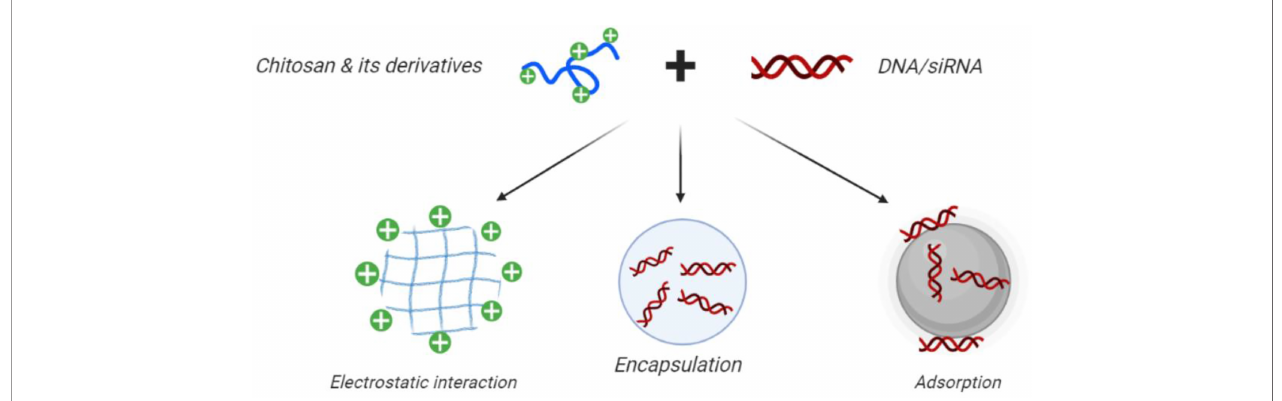
FIGURE 4 | Use of CH in gene therapy and gene silencing. Chitosan nanoparticles can be loaded with plasmid DNA, antisense oligonucleotides, or small interfering RNAs for targeted gene silencing. Positively charged CH can readily form polyelectrolyte complexes with negatively charged nucleic acids. This fi gure adapted from (Santos-Carballal et